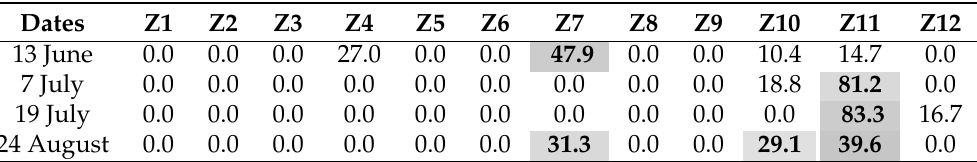
Table 3. Temporal variation in the percentage of data points in each zone for different phenology stages of wheat. The zones with high percentages of points at a particular phenology stage are highlighted in